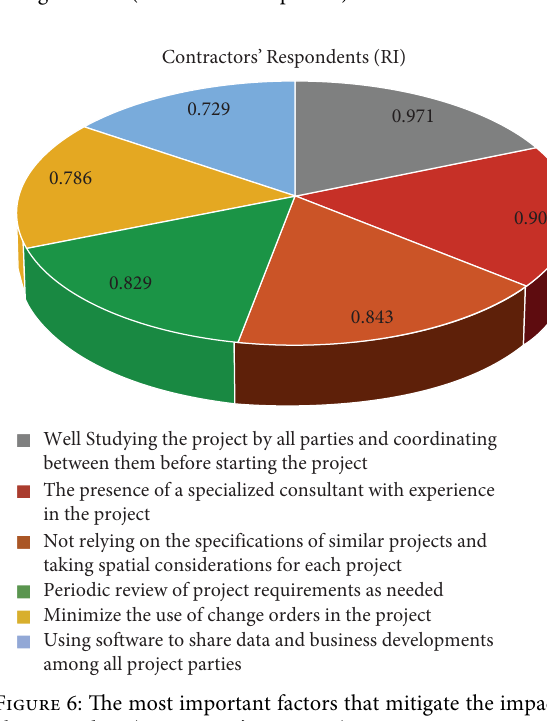
Figure 5: )e most important factors that mitigate the impacts of change orders (consultants’ responses).